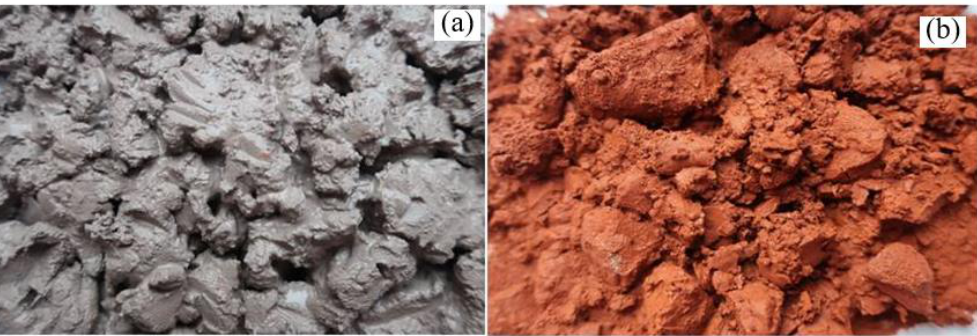
Figure 1. Digital photographs of the raw samples — ( a ) Shanxi red mud and ( b ) Shandong red